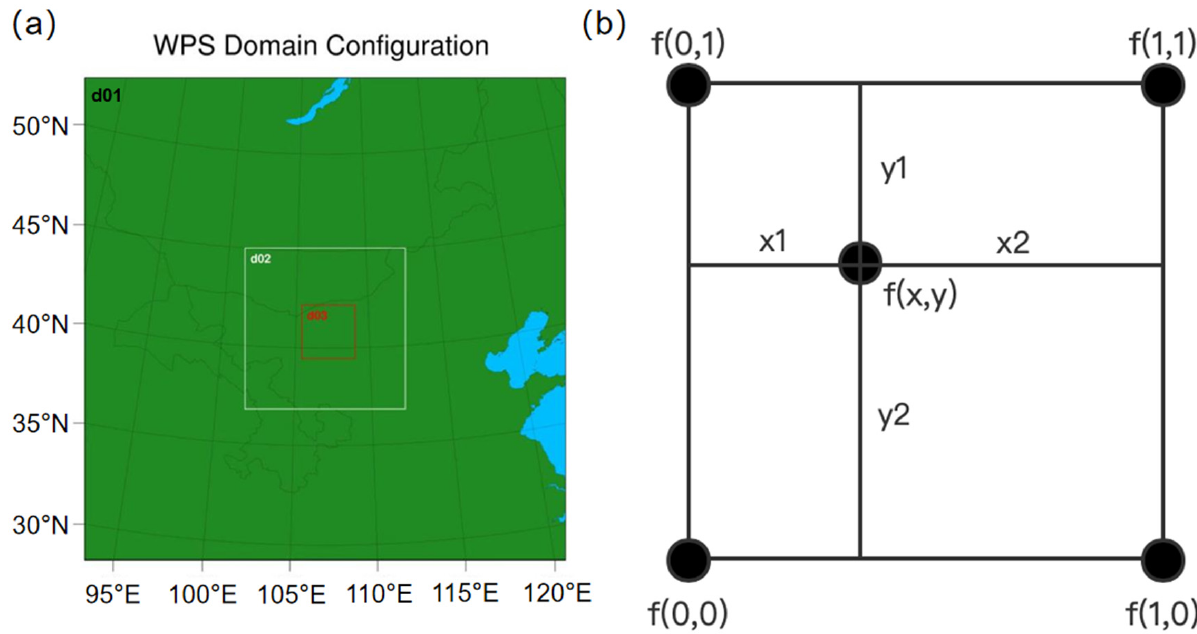
Table 1. Parameterization scheme of WRF model for the simulation of Gobi grassland wind farm. Figure 2. ( a ) Schematic diagram of triple simulation domains of numerical WRF simulation and ( b ) schematic diagram of interpolation method.